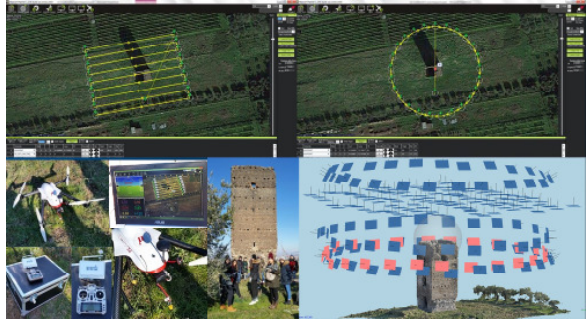
Figure 5. UAVs survey and PhotoScan final